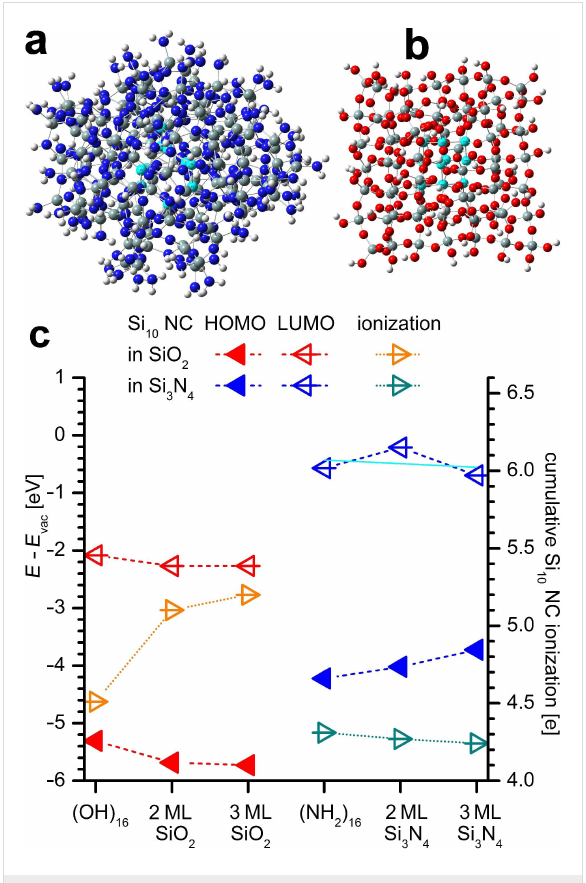
Figure 2: Evolution of energy offsets for SiO 2 - and Si 3 N 4 -embedded Si 10 -NCs (0.8 nm size) as a function of embedding SiO 2 - or Si 3 N 4 - thickness: (a) Si 10 -NC embedded in 3 ML Si 3 N 4 after structural optimi- zation. (b) Si 10 -NC embedded in 3 ML SiO 2 after structural optimiza- tion. For atoms colors see Figure 1. (c) Evolution of HOMO and LUMO energies relative to vacuum energy E vac (left scale) and total Si 10 -NC ionization (right scale) with increasing thickness of embedding dielec- tric. For SiO 2 -embedding, the ICT and the associated shift in HOMO and LUMO energies away from E vac saturate quickly. For Si 3 N 4 - embedding, the HOMO energy shifts towards E vac . The LUMO energy shift varies around a constant value as shown by a linear fit to LUMO energies (cyan line) as a function of Si 3 N 4 thickness. The positive NC ionization remains nearly unchanged. These features are due to the positive electron affinity X and the anionic nature of N, resulting in electron delocalization from the NC (ionization) without strong electron localization at N as is the case for